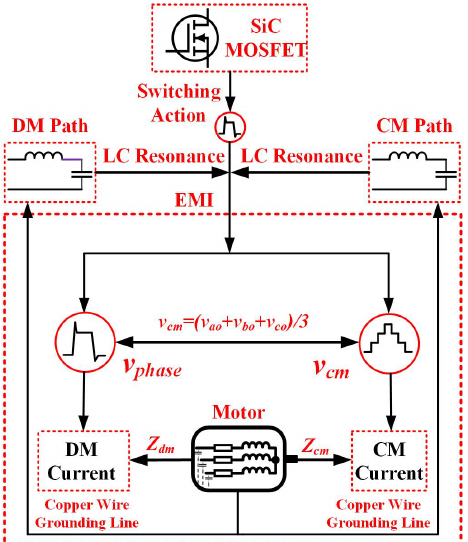
Figure 25. Summarization of the relationship between motor impedance and EMI in motor drives.